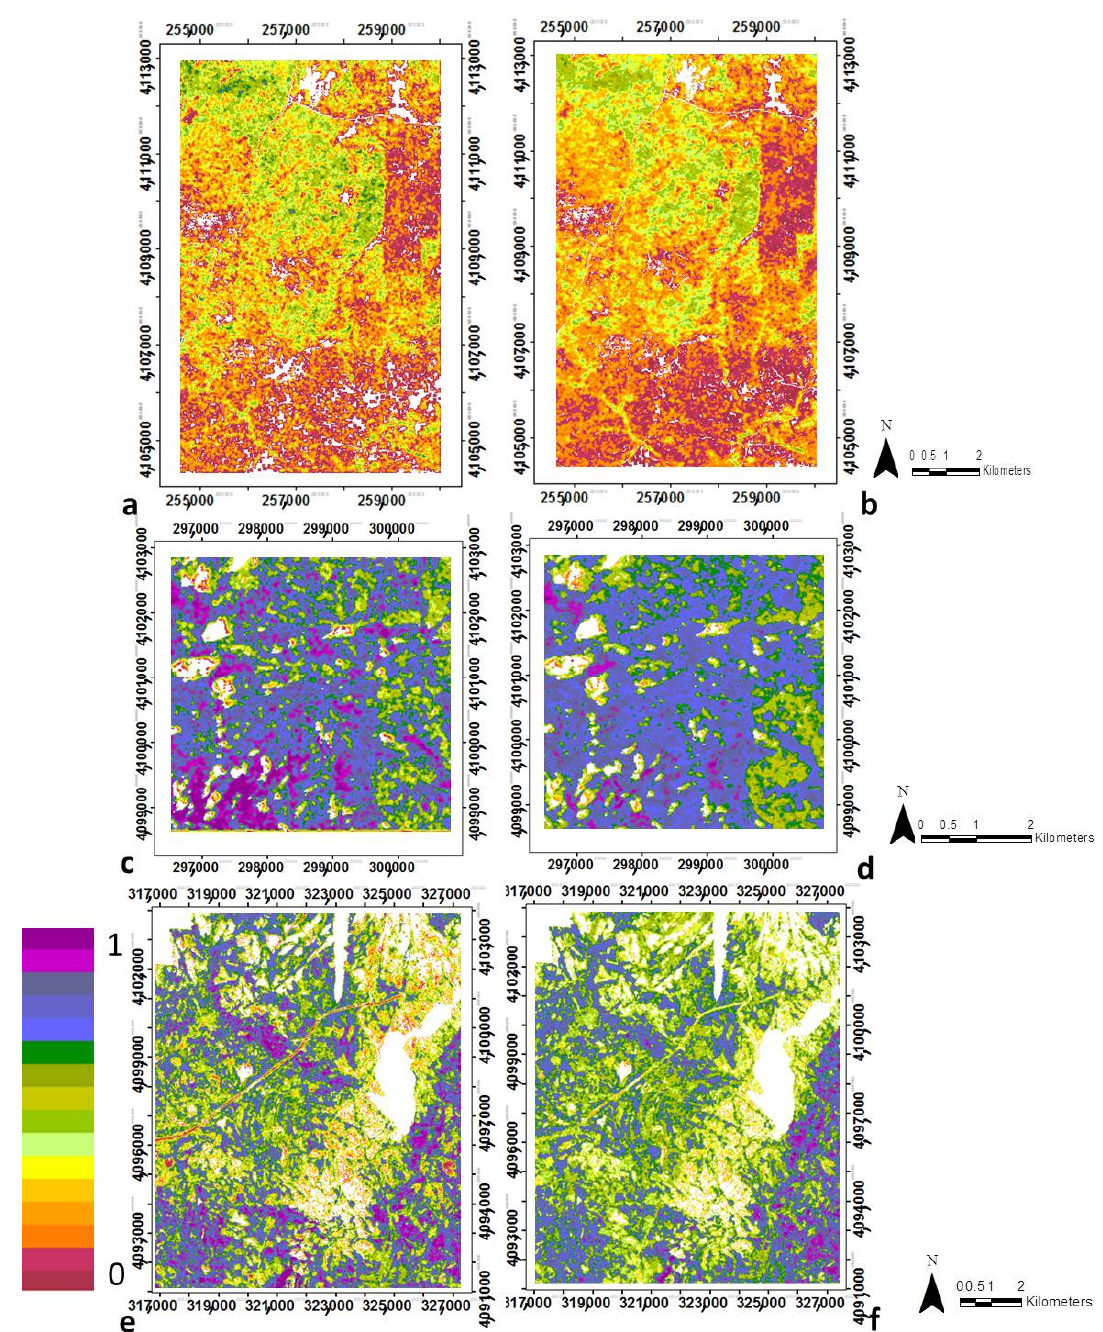
Figure 3. Spatial distribution of biomass from LiDAR-derived data ( a , c , e ) and from Random Forests regression using optical metrics ( b , d , f ), for SJER ( a , b ), SOAP ( c , d ) and TEAK ( e , f ). White areas are non-vegetated, either water bodies, rock or bare ground, etc. See Supplementary Materials, Table S5 for the ranking of the input metrics. Note regions are not to scale due to optimizing images and site size differences.